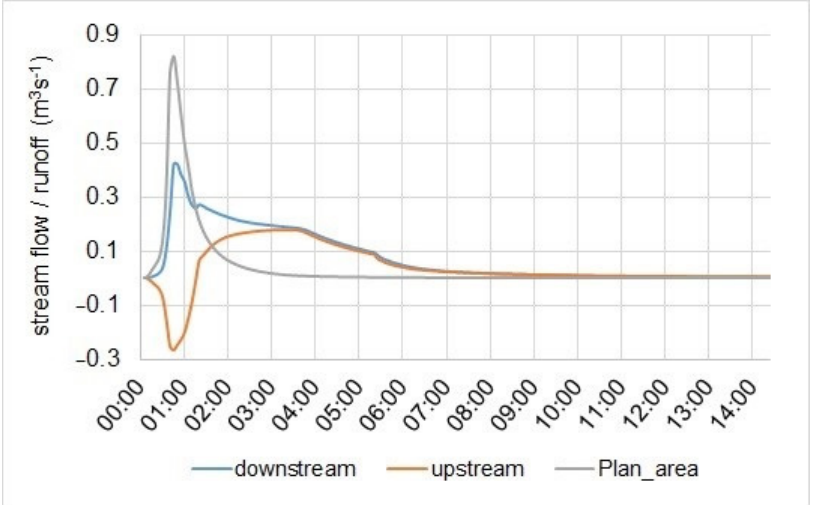
Figure 11. Runoff from plan area and simulated stream flow with rain event 1h-100a in the conduit directly downstream (max. flow = 0.42 m 3 s − 1 ) and upstream (min. flow = − 0.264 m 3 s − 1 ) of the discharge point from the new residential site.